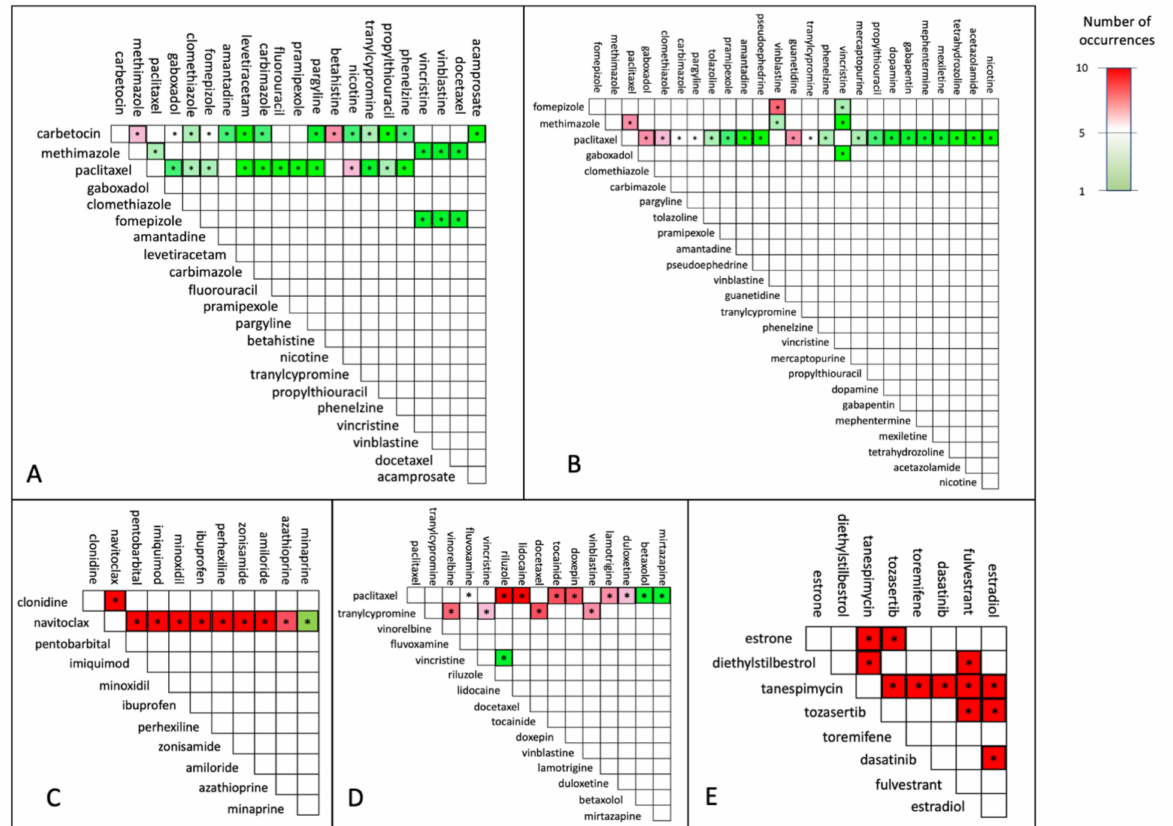
Figure 3. Overview of drug combinations obtained for the cancers under consideration. ( A )—invasive breast cancer (BRCA); ( B )—prostate adenocarcinoma (PRAD); ( C )—colon adenocarcinoma (COAD); ( D )—lung squamous cell carcinoma (LUSC); ( E )—hepatocellular carcinoma best pairs